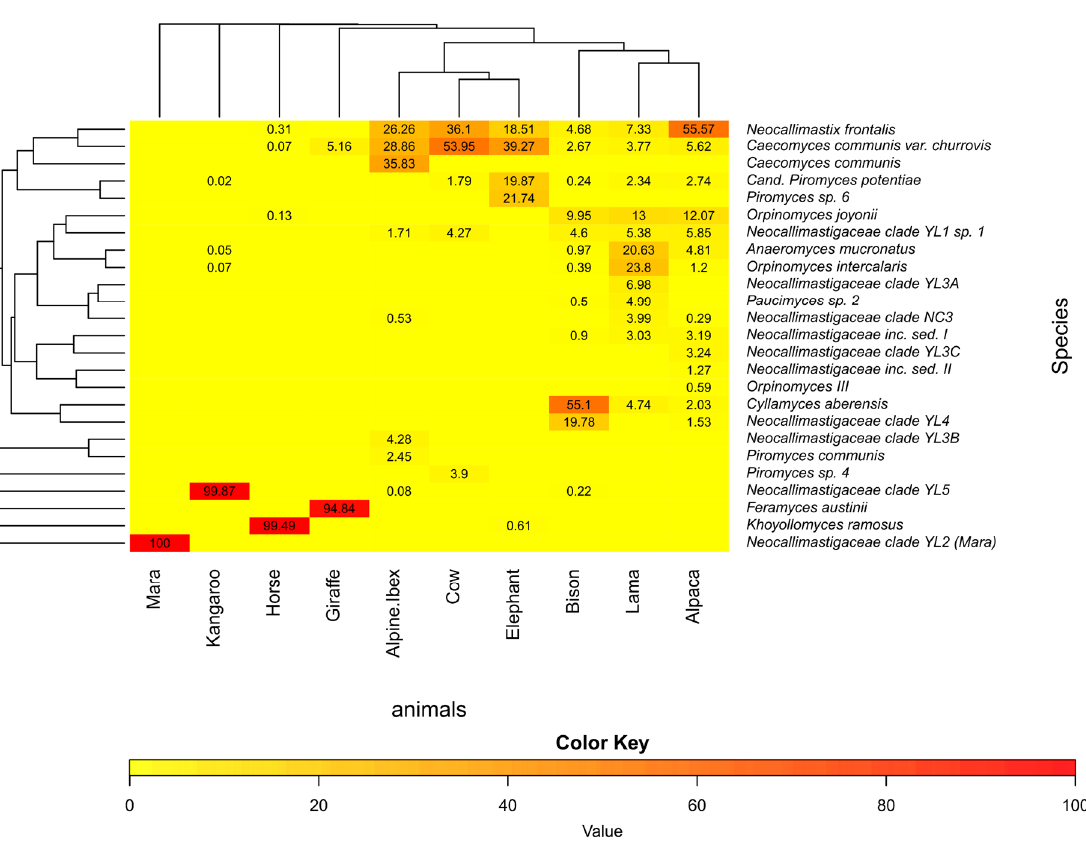
Figure 5. Cluster analysis heatmap visualizing the relative abundance in percentage of ASV reads per genus/species to describe the Neocallimastigomycetes community composition in fecal samples from ten different herbivore animals. The original table can be found as Supplementary Data